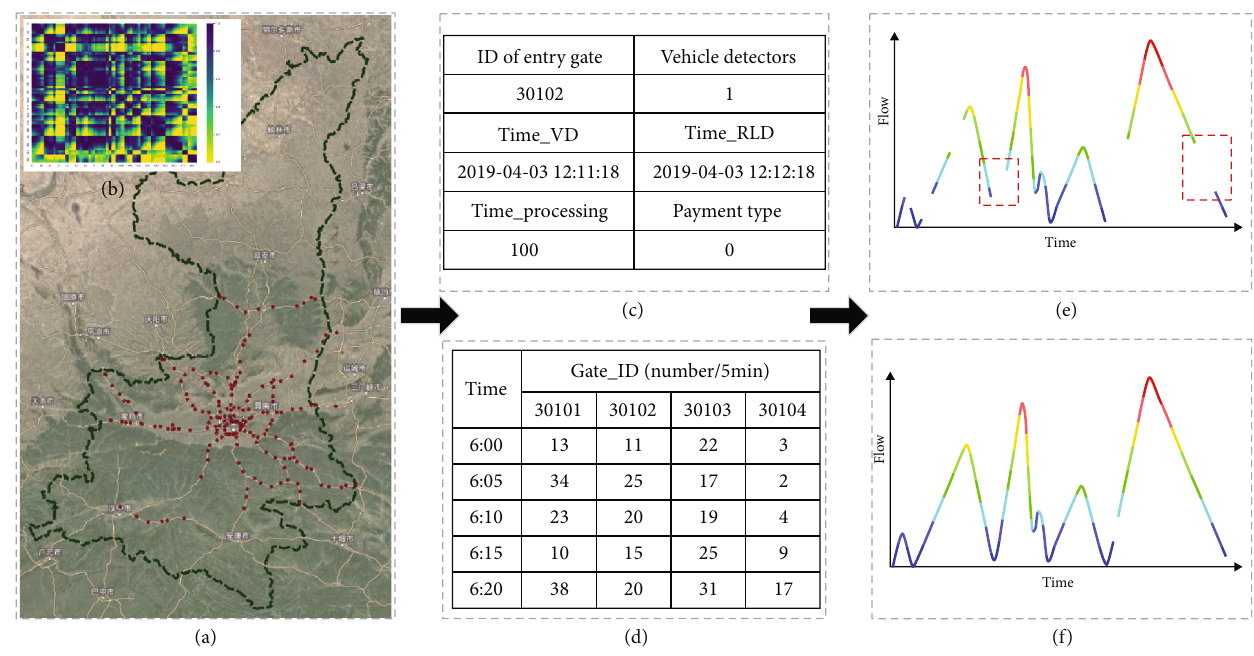
Figure 10: Data sources of freeway tolls and data processing of tra ffi c